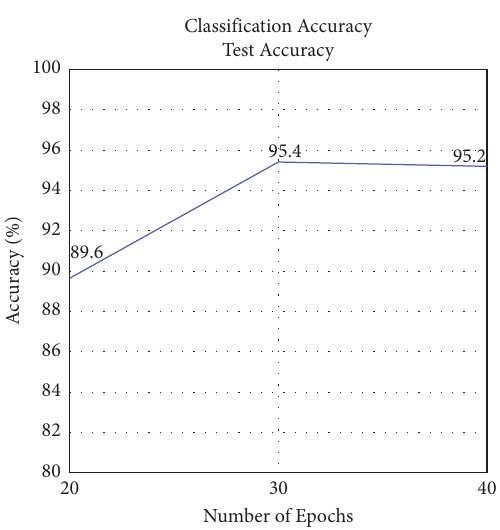
Figure 8: Classifcation accuracy of AlexNet using Adam optimizer.